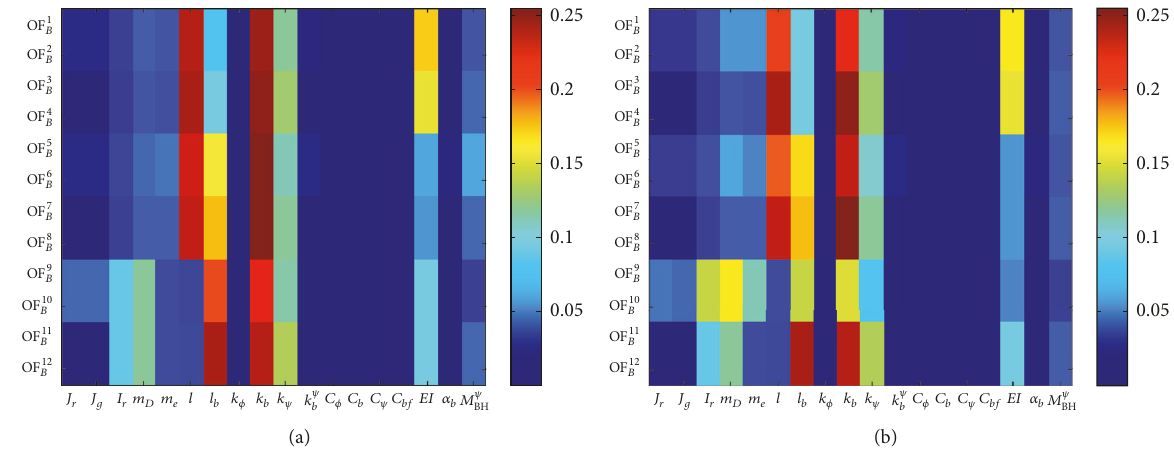
Figure 13: Primary sensitivity 𝑆 𝑖 (a) and total sensitivity ST 𝑖 (b) indices for bending model with bearing defect assumption for OS 1 .